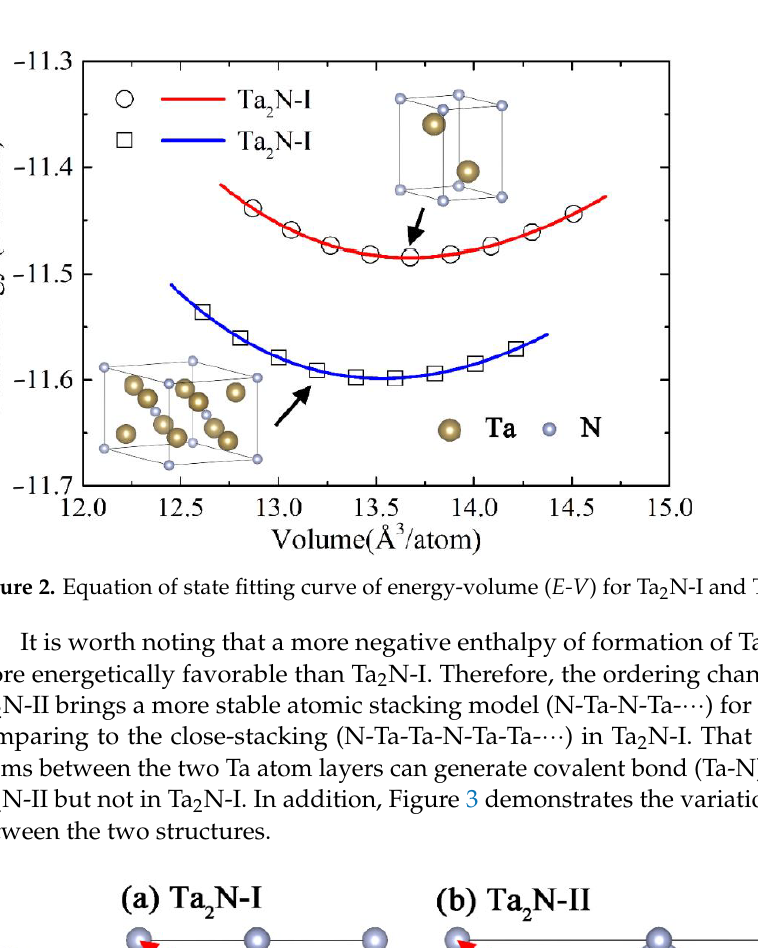
C (GPa) of Ta 2 N-I and Ta 2 N-II.